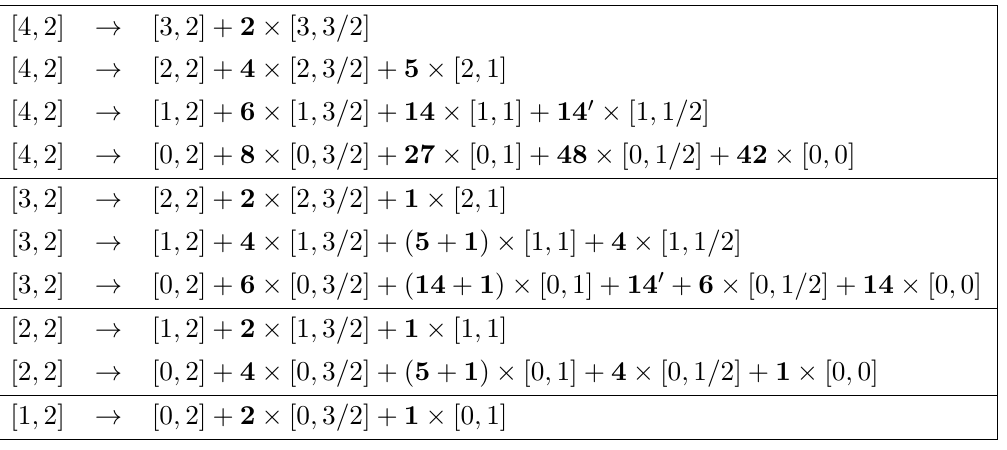
Table 9 . Branchings of massive spin-2 multiplets under Sp( N 0 ) (cid:2) Sp( N (cid:0) N 0 ) (cid:26) Sp( N ).